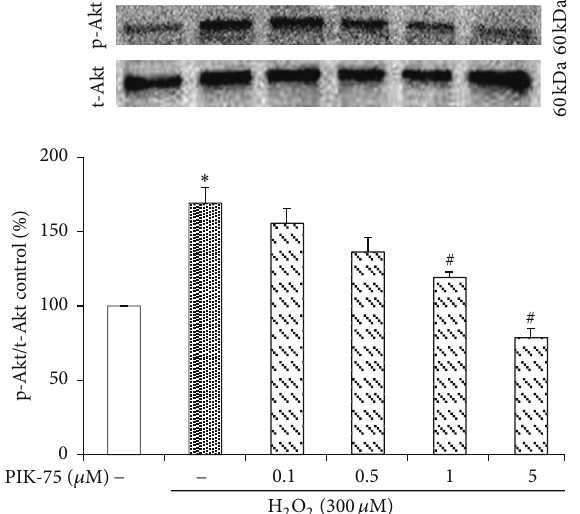
Figure 5: Effect of PIK-75 on p-Akt activation in feline EECs stimulated by H 2 O 2 . Representative Western blot analyses of p- Akt expressed in feline EECs ( 𝑛 = 4 ). EECs were pretreated with PIK-75 at different concentrations, followed by the stimulation with H 2 O 2 (300 𝜇 M, 30 minutes). t-Akt expression was used as a reference. Data are expressed as means ± S.E of four experiments (Student’s t -test; ∗ 𝑃 < 0.05 versus control, # 𝑃 < 0.05 versus H 2 O 2 alone).